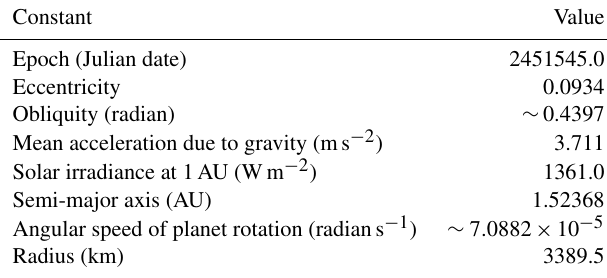
Table 1. Orbital, planetary and atmospheric parameters in our